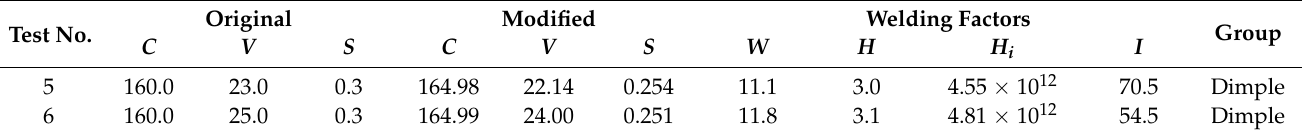
Table 14. Results of welding parameters modified by optimization